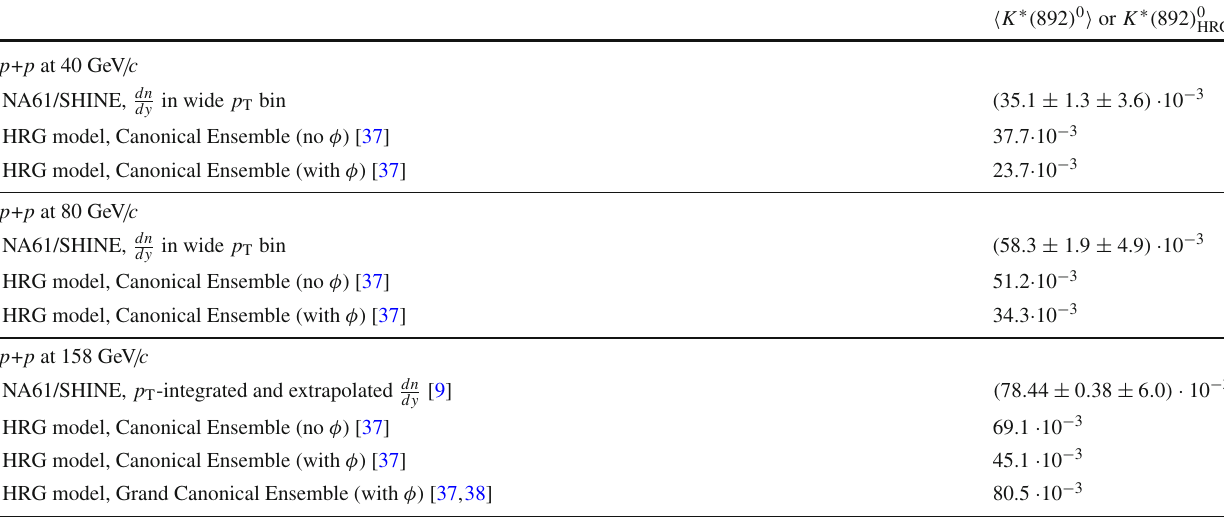
Table 9 The K ∗ ( 892 ) 0 mean multiplicities for inelastic p+p interac- tions at 40–158 GeV / c beam momenta (this analysis and Ref. [9]) com- pared to the theoretical multiplicities of K ∗ ( 892 ) 0 mesons predicted by